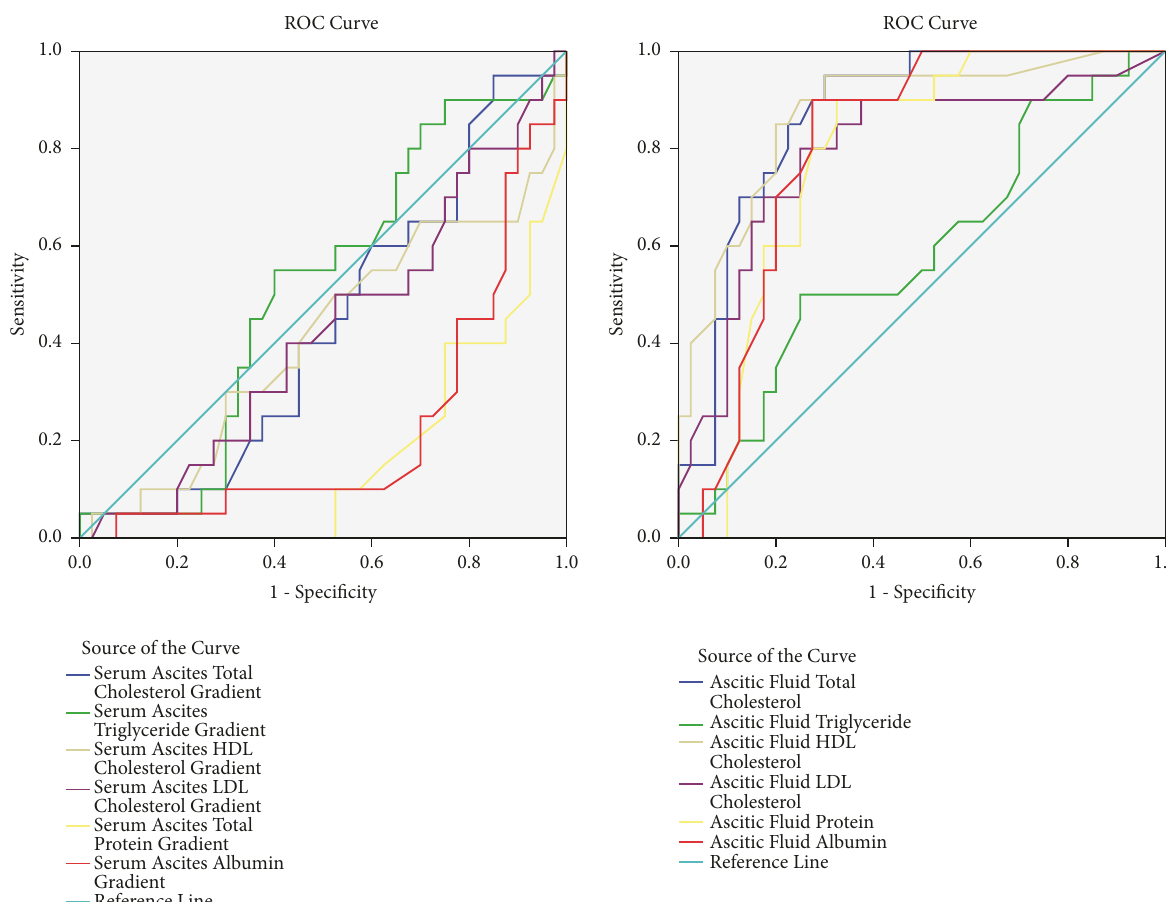
Figure 1: ROC curve analysis between malignant vs. nonmalignant